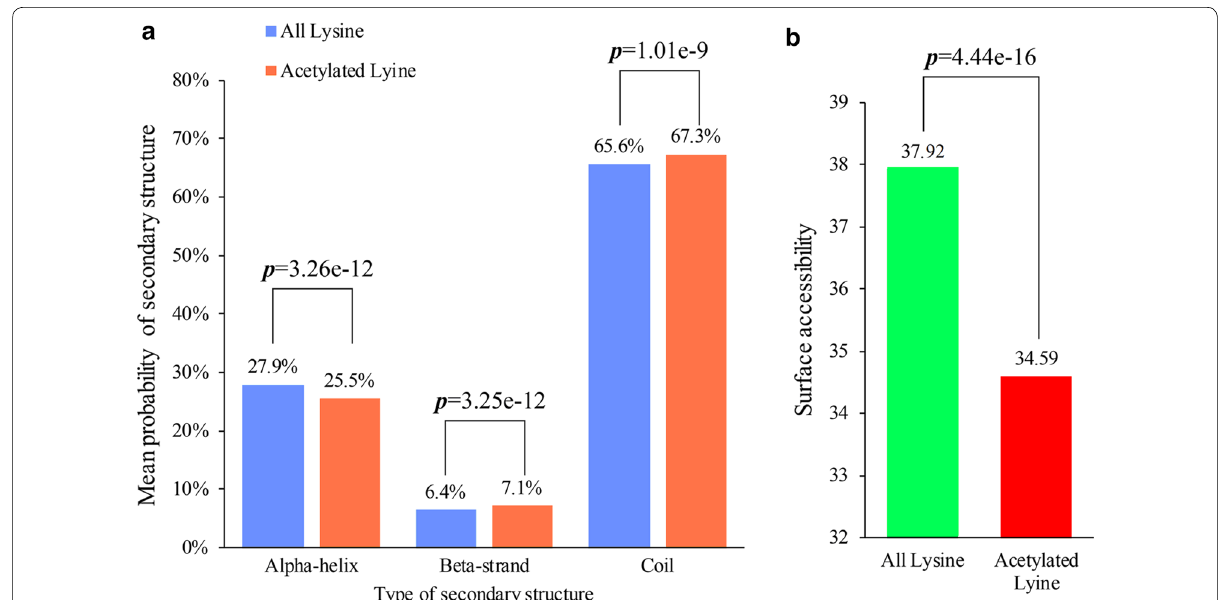
Fig. 5 Secondary structure analysis of acetylated proteins. a Probabilities of lysine acetylation in the structures of alpha-helix, beta-strand and coil. b Predicted surface accessibility of acetylation